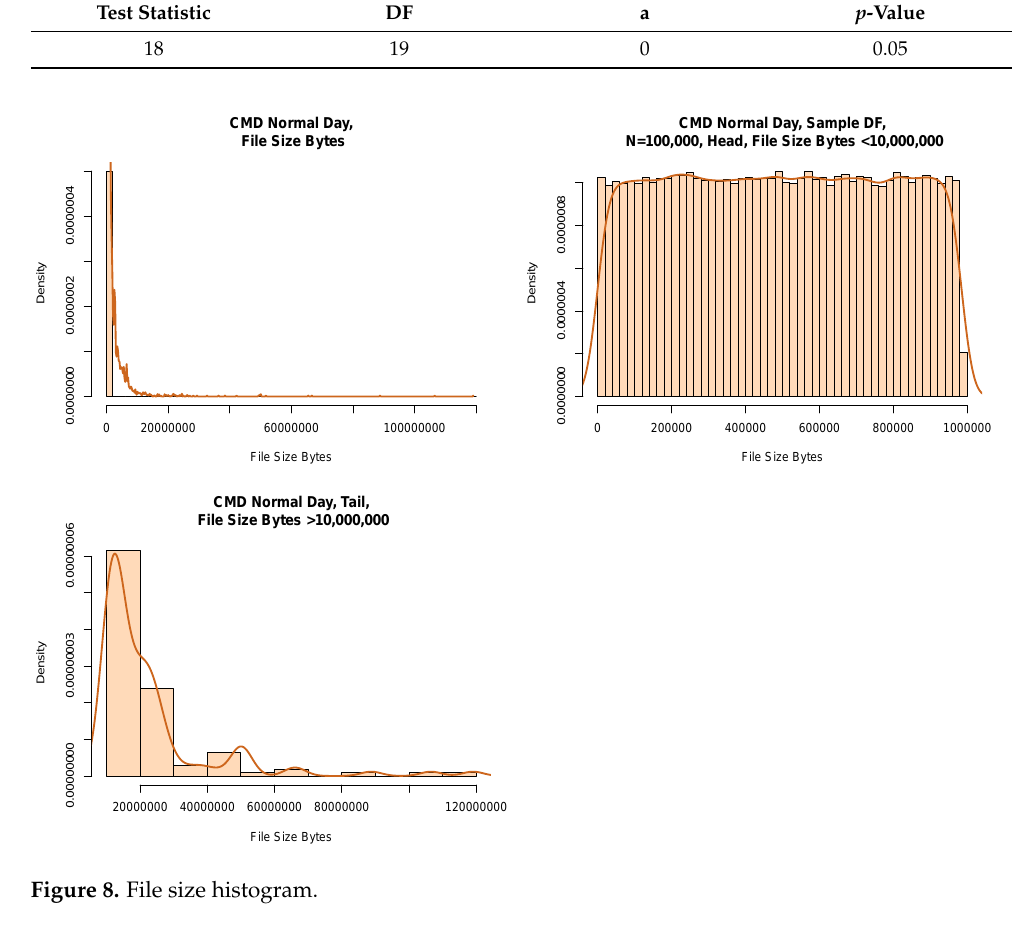
Figure 8. File size